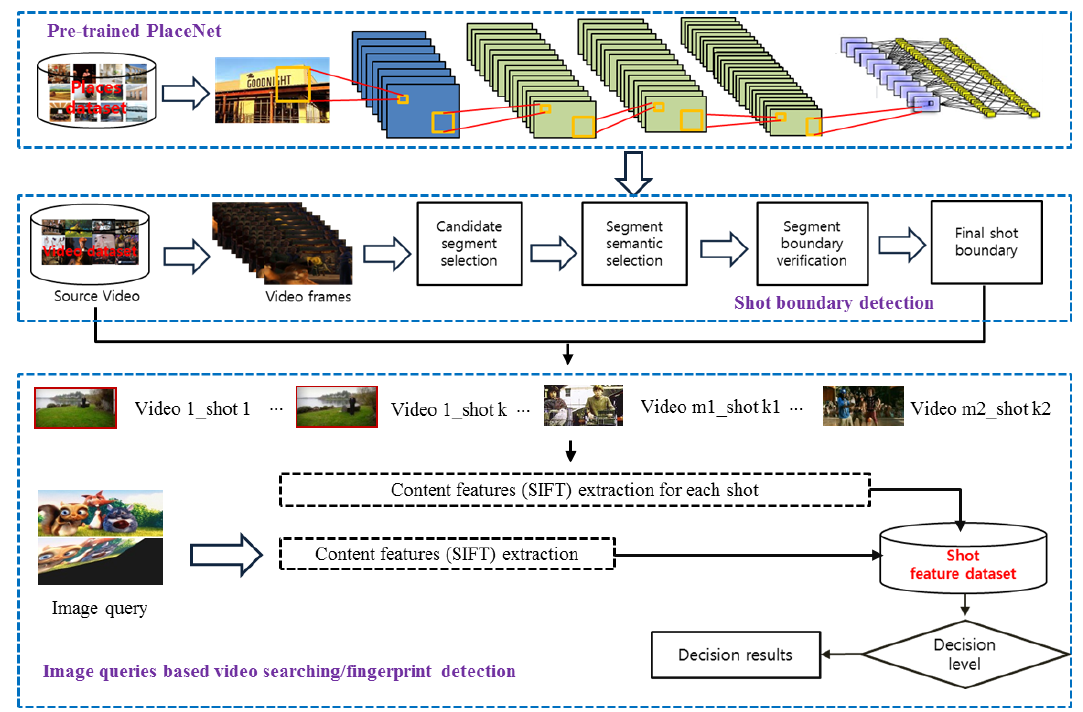
Figure 1. An illustration of the proposed image query based video searching/fingerprint detection process. SIFT, Scale-Invariant Feature Transform.